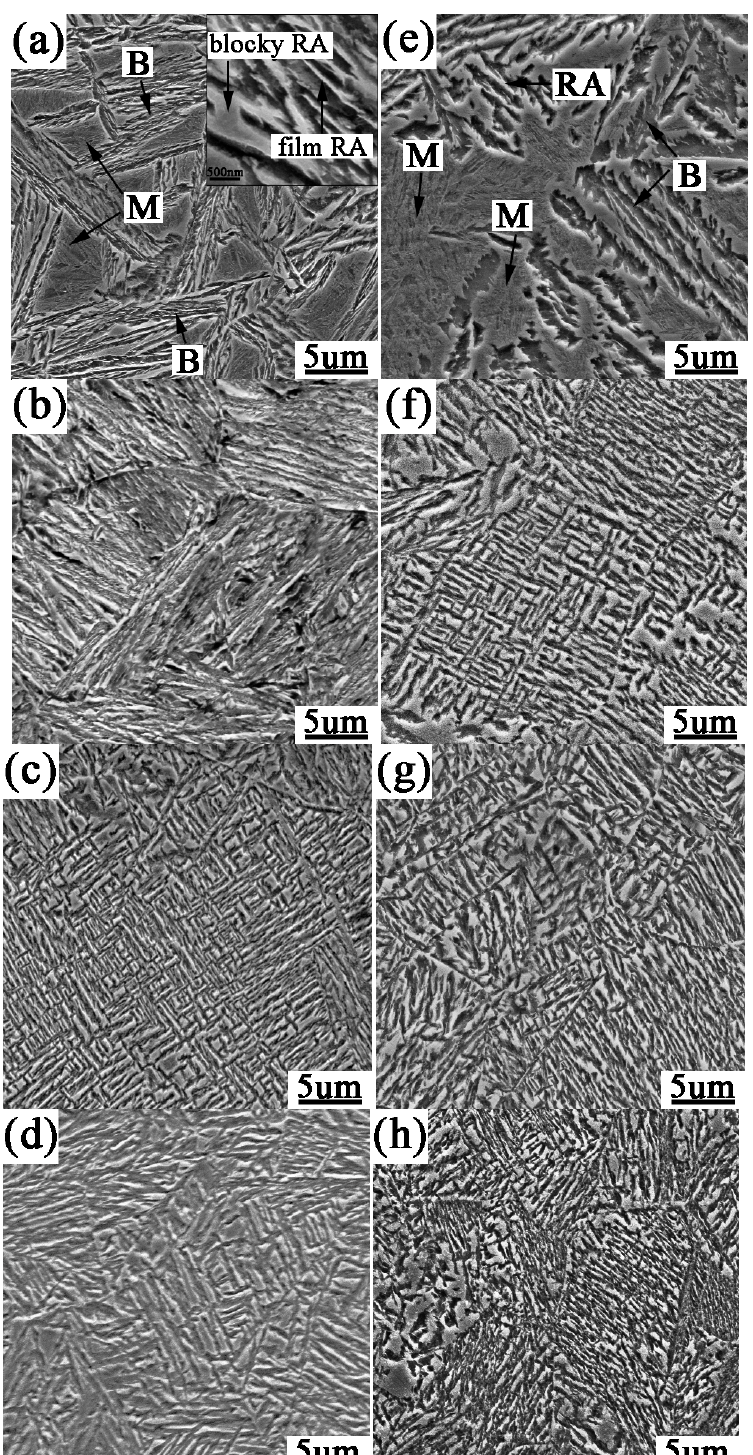
Figure 3. SEM micrographs of samples with different ausforming conditions: ( a ) without deformation, 300 °C; ( b ) 0.1, 300 °C; ( c ) 0.2, 300 °C; ( d ) 0.3, 300 °C; ( e ) without deformation, 350 °C; ( f ) 0.1, 350 °C; ( g ) 0.2, 350 °C; ( h ) 0.3, 350 °C.